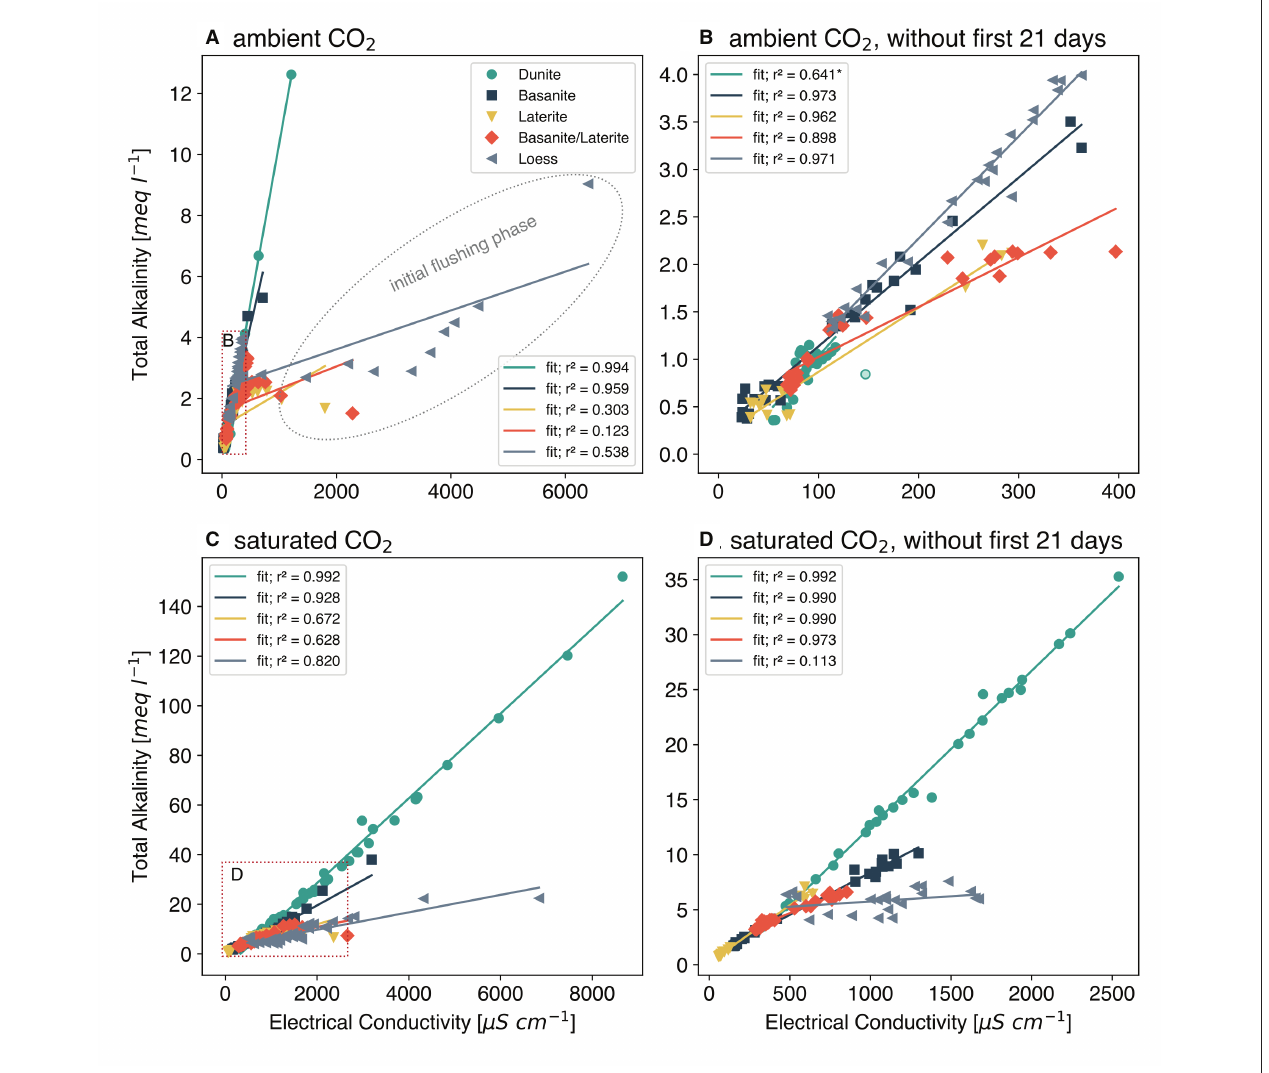
FIGURE 1 | Relationship between alkalinity and electrical conductivity in the outflow of columns which were filled with different rock and soil materials and watered for about 300 days. Data fit: linear least squares fit with the coefficient of determination r 2 given in the legend. *One outlier data point (transparent green circle) was removed to calculate this regression. Red rectangles indicate the areas of figures (B,D) . (A) Experiment under ambient ( ∼ 0.046%) CO 2 . (B) Ambient CO 2 , without first 21 days. (C) Experiment under saturated (100%) CO 2 . (D) Saturated CO 2 , without first 21